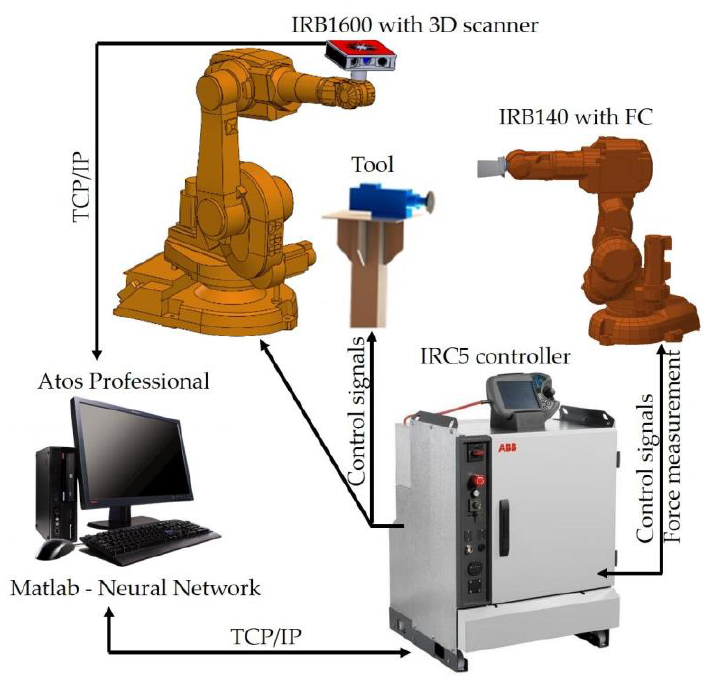
Figure 3. Schematic diagram of communication between robotic cell devices.